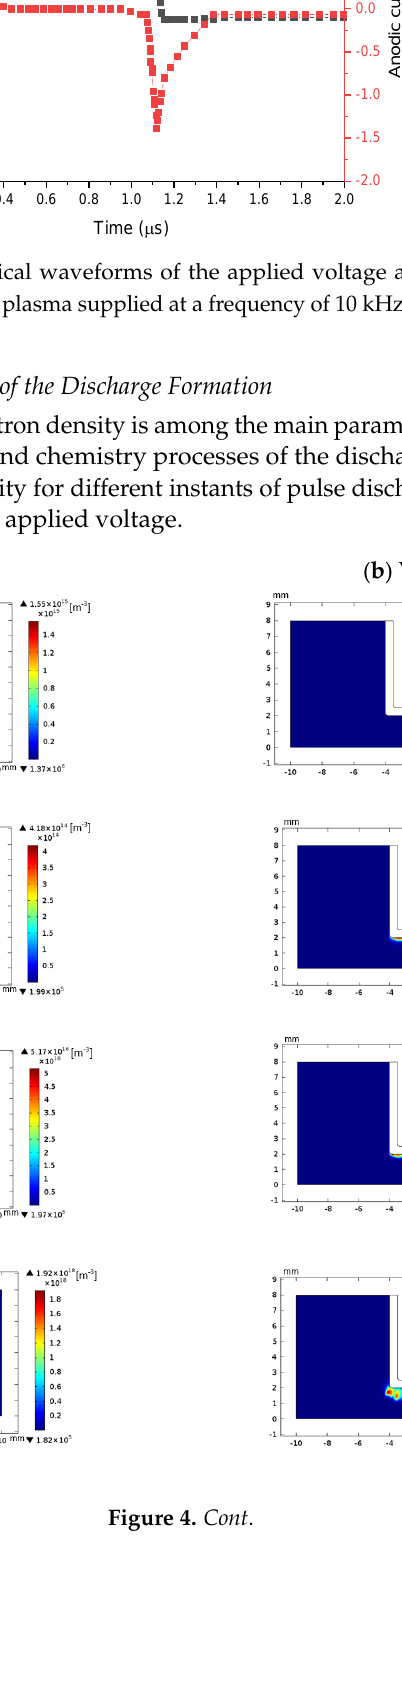
Figure 3. Typical waveforms of the applied voltage and the anode current measurement of the FE-